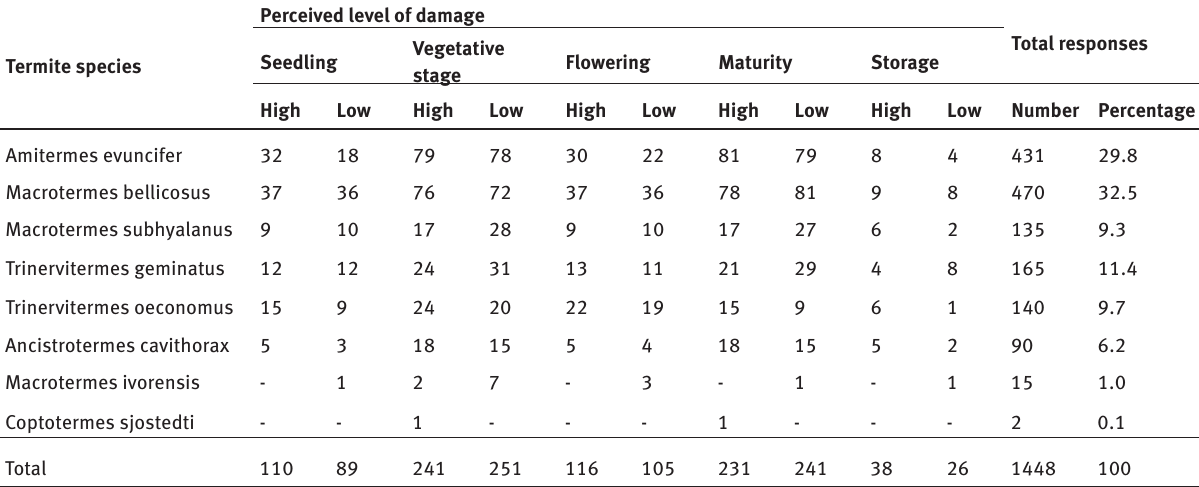
Table 7 : Farmers perception of levels of damage caused by different termites species at different development stage of maize and storage (N = 300)